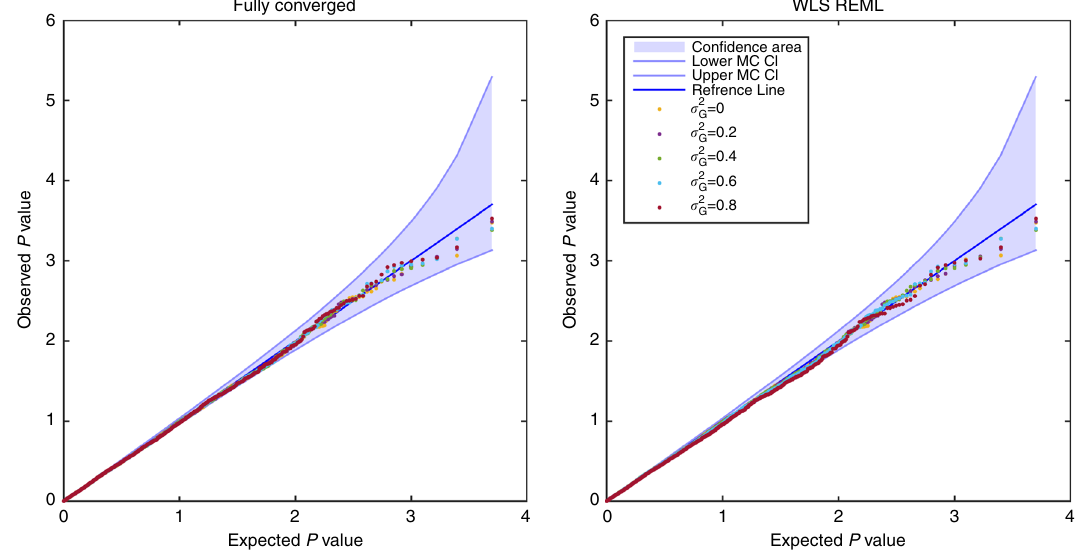
Fig. 2 Comparison of random effect estimators for fi xed effect inference (Simulation 3). Results shown for the distribution of null ( β 1 = 0) parametric P - values from the fi xed effects score statistic derived from the simpli fi ed REML function using fully converged (left) and non-iterative (right) random effect estimator, for the GRM from 300 unrelated individuals. There is no apparent difference between the two random effect estimators, and both are consistent with a valid (uniform) P -value distribution. Con fi dence bounds created with the results of ref. 59 where ordered P -values follow beta